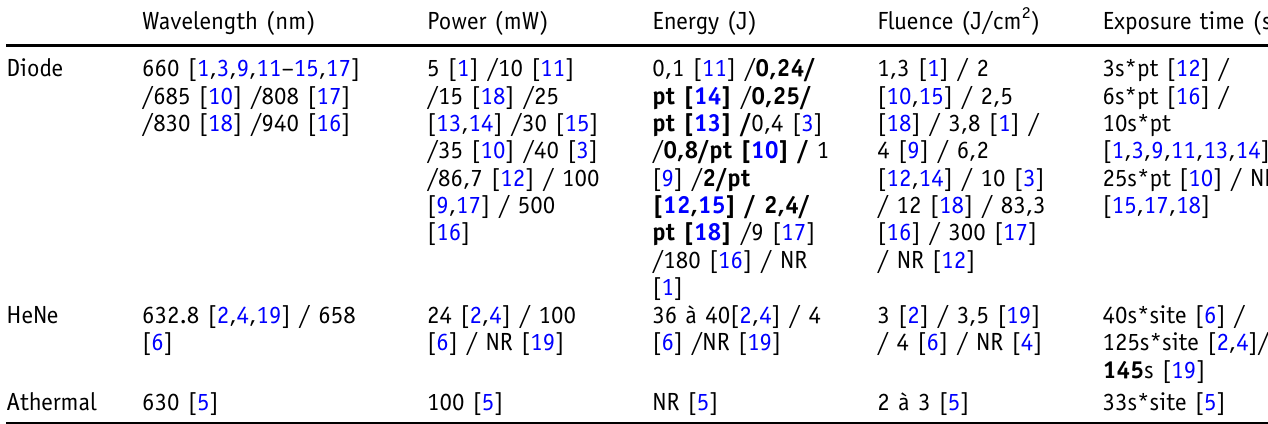
Table II. Wavelength, power, energy, fl uence, exposure time parameters. In bold, the energies that were reported per point. In diode laser, as two wavelengths were used in one test, the number of values is higher than the number of